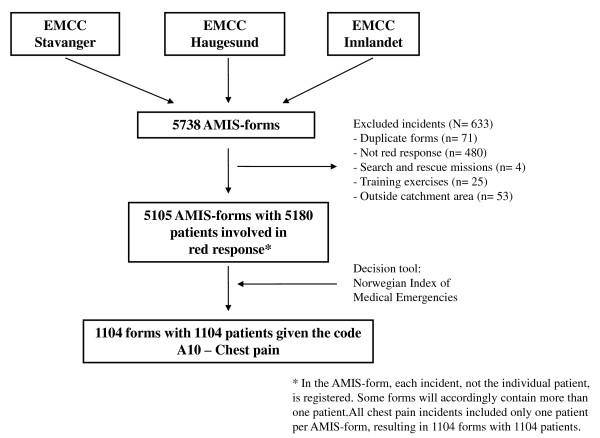
Flow chart of AMIS forms received for registration, with both excluded and included incidents.